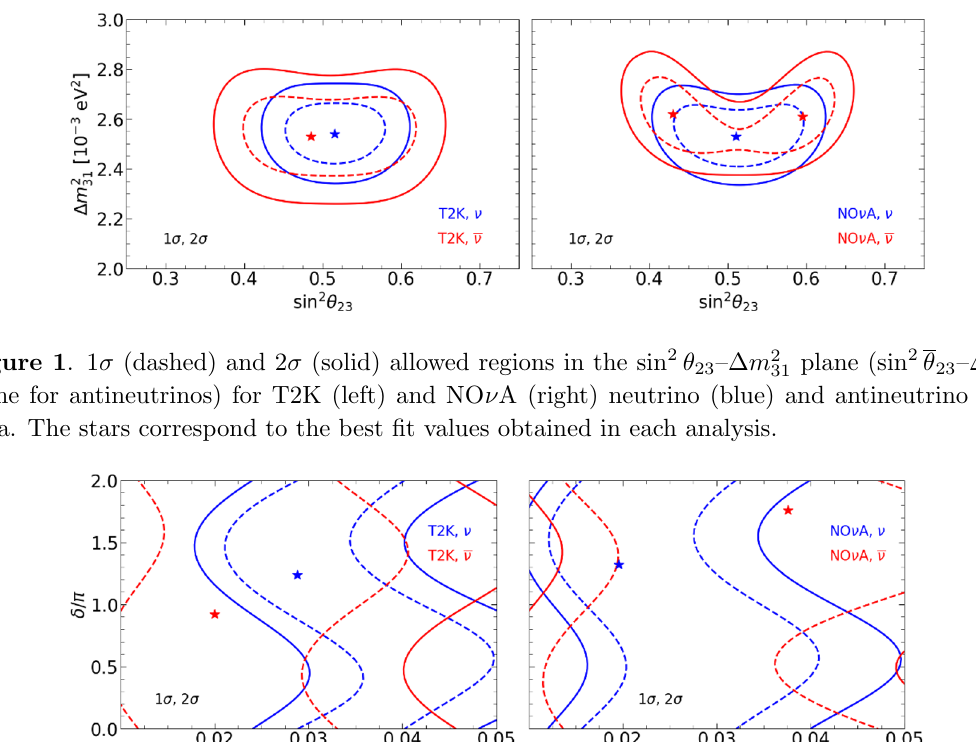
Figure 2 . 1 (cid:27) (dashed) and 2 (cid:27) (solid) allowed regions in the sin 2 (cid:18) 13 { (cid:14) plane (sin 2 (cid:18) 13 { (cid:14) plane for antineutrinos) for T2K (left) and NO (cid:23) A (right) neutrino (blue) and antineutrino (red) data. The stars correspond to the best (cid:12)t values obtained in each